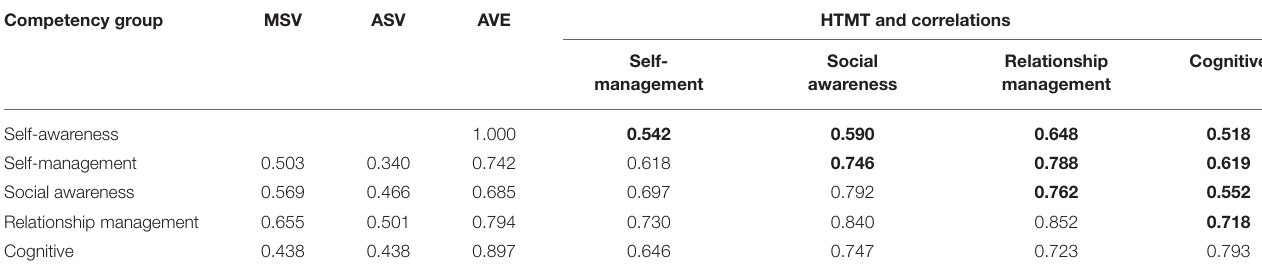
TABLE 4 | Convergent and discriminant